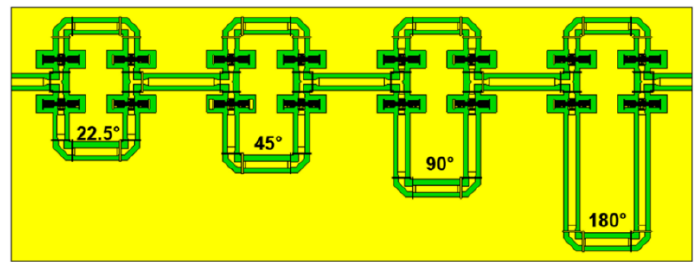
Figure 1. Top view of the 4-bit True-Time Delay (TTD) phase shifter schematic topology. The upper sections correspond to the reference path with a total 0° phase shift.